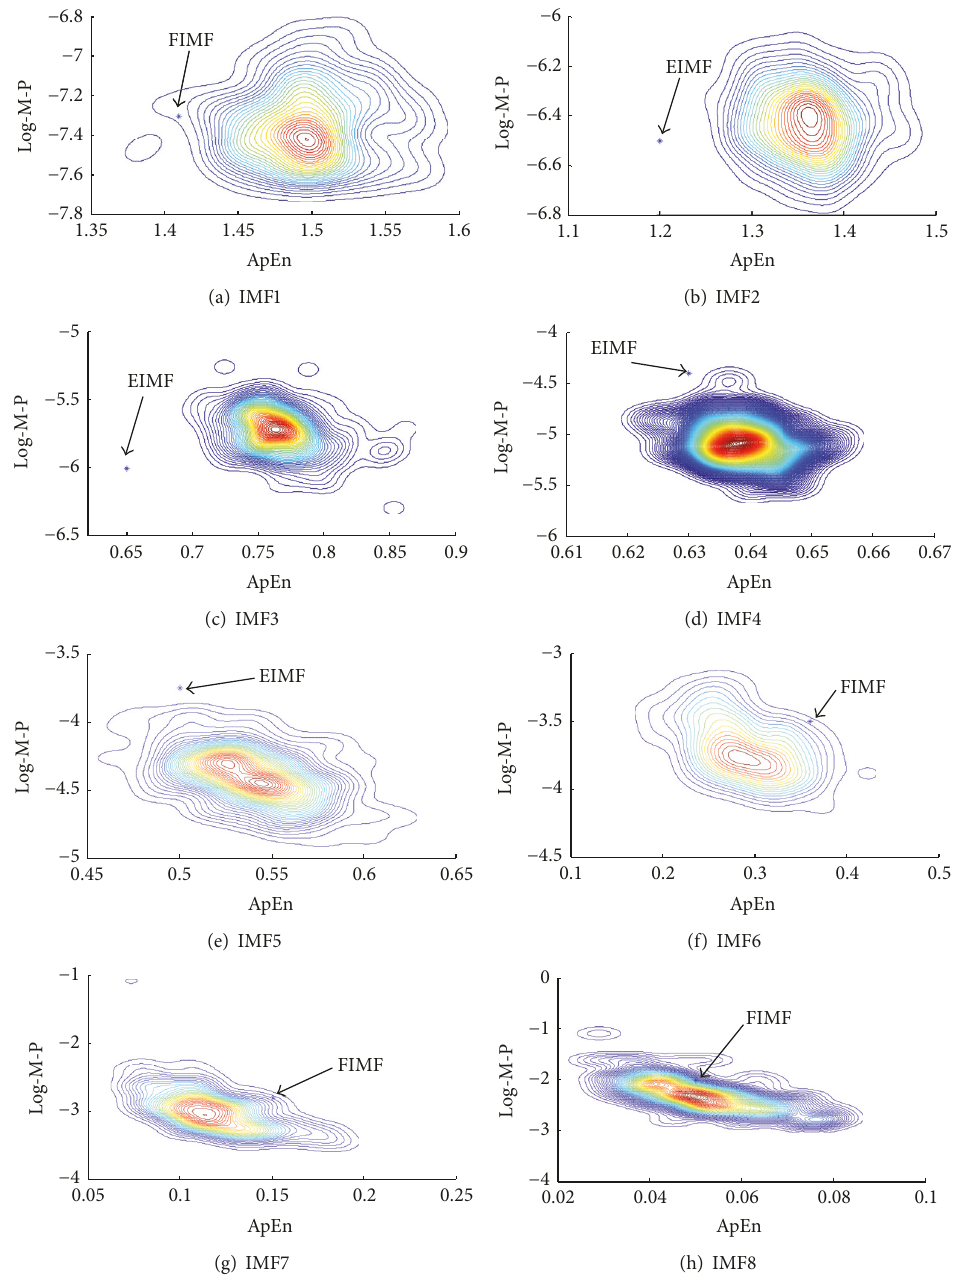
Figure 7: The IMF-ApEn distribution of steering wheel angle and white